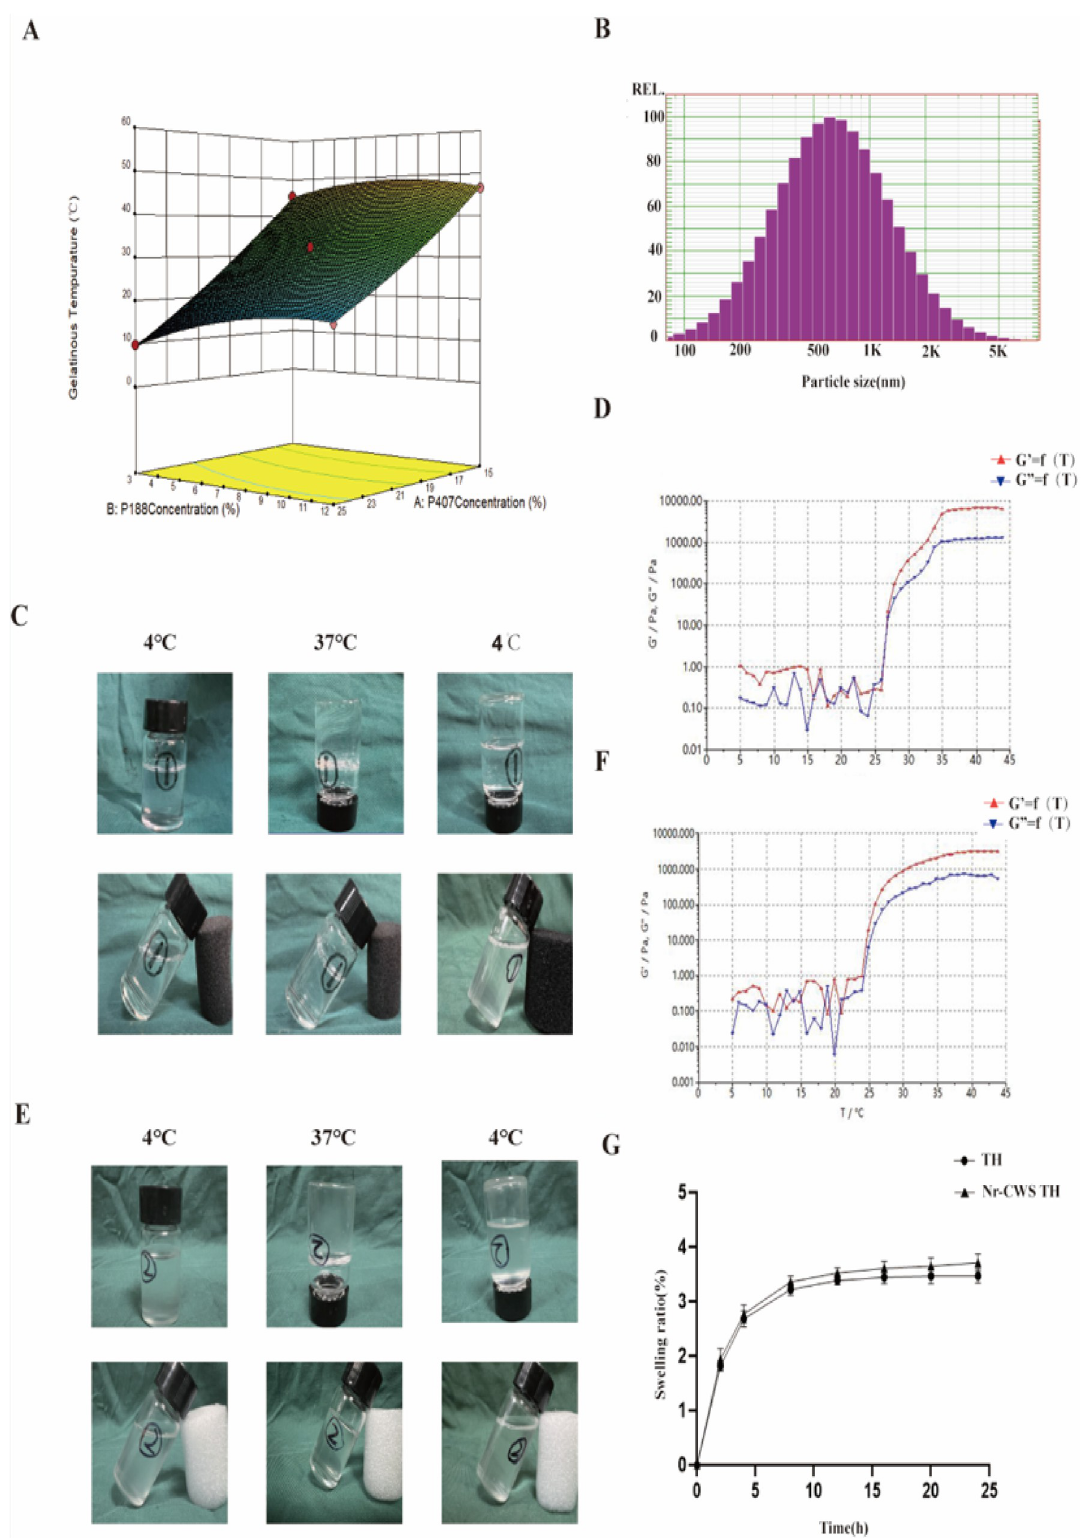
Fig 1. The characterization of the hydrogel. The characterization of the hydrogel. A) Impact of the formulation compositions on the gelation temperature (GT) of blank hydrogel. The higher concentration of P407, the lower GT of hydrogel. The GT of blank hydrogel